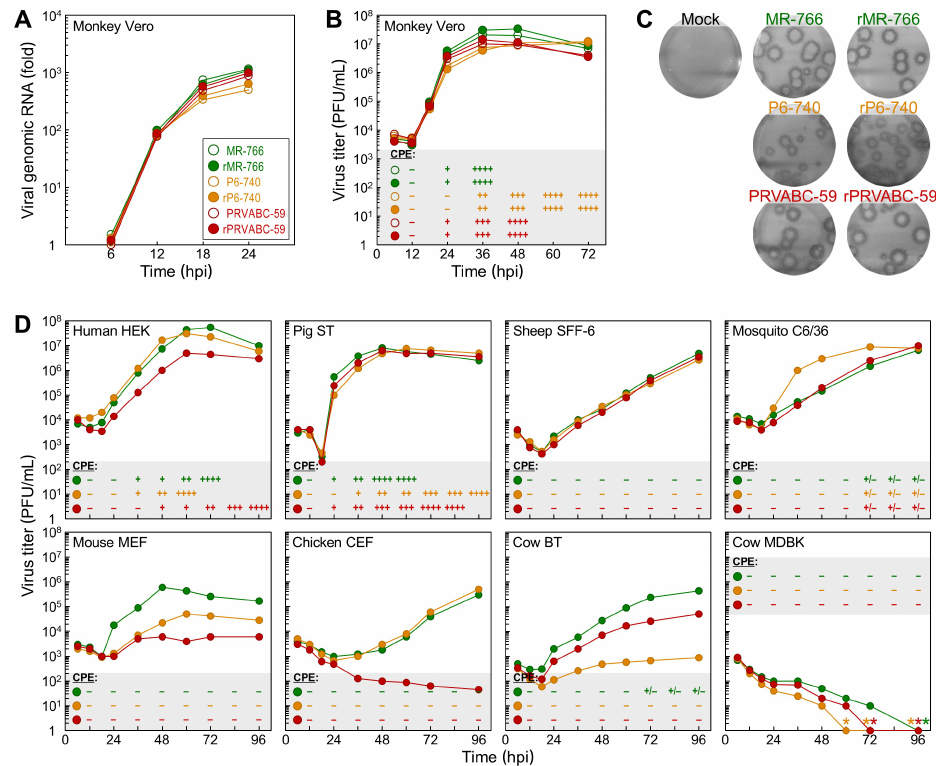
Figure 3. ZIKV replication kinetics and cytopathogenicity in cell cultures depend on the particular combination of virus strain and host cells. ( A – C ) Replicative and cytopathic properties of three cloned cDNA-derived ZIKVs (rMR-766, rP6-740, and rPRVABC-59) and their uncloned parental ZIKVs (MR-766, P6-740, and PRVABC-59) in Vero cells. Cells were infected with each of the six ZIKVs (MOI = 1). At the time points indicated after infection, cells were lysed to examine the accumulation levels of viral genomic RNA by real-time RT-PCR with a ZIKV-specific fluorogenic probe ( A ), and supernatants were collected to analyze the production levels of progeny virions by plaque assays on Vero cells ( B ). At 5 days post-infection, cell monolayers maintained under a semisolid overlay